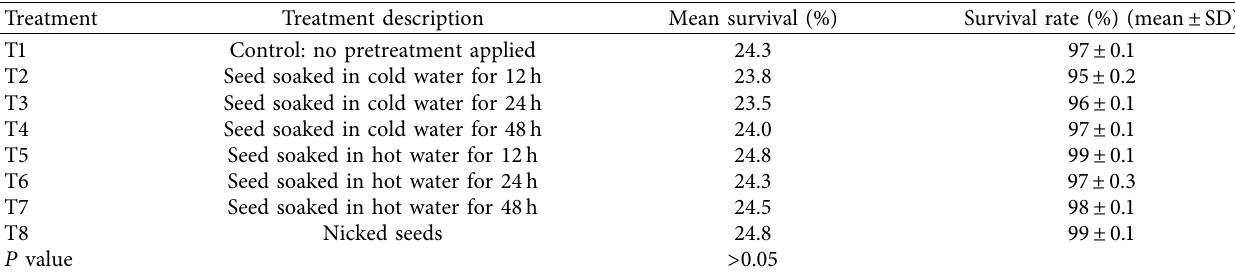
Table 4: Mean survival and survival rate of Senna spectabilis seedlings, 60 days after sowing. Treatment